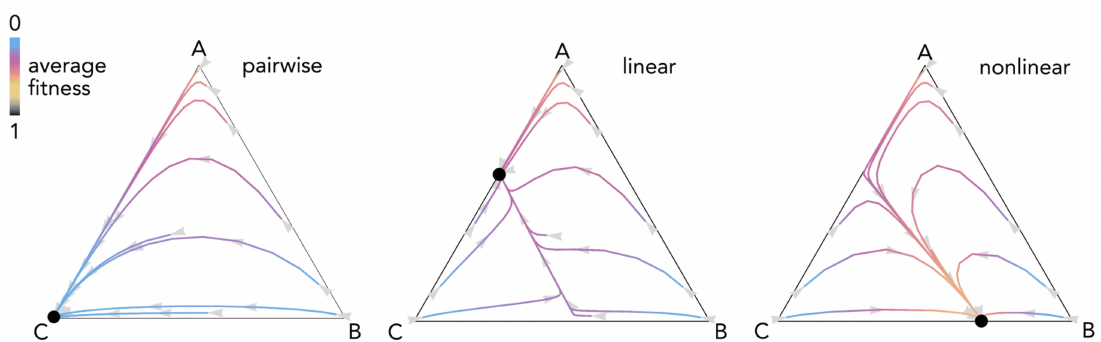
Figure 8. Three-strategy game. The dynamics of the three strategies A , B , and C with fitness given by Equations (33)–(35) with n = 20, h 1 = 0.2, h 2 = 0.4, r = 0.5 with pairwise interactions, linear benefits ( s 1 = s 2 = 0.01) or nonlinear benefits ( s 1 = 50, s 2 =